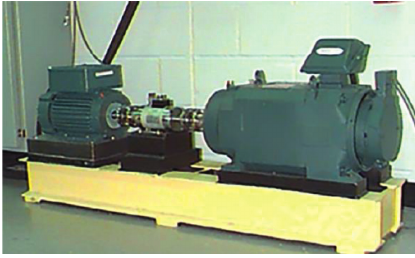
Figure 6: Test stand used by CWRU.